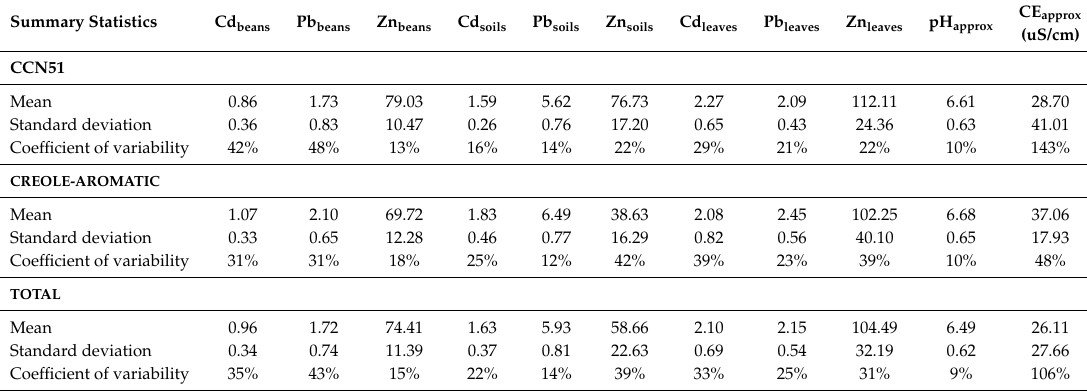
Table 3. Summary statistics on heavy metal content in beans, soils and leaves according to cocoa variety